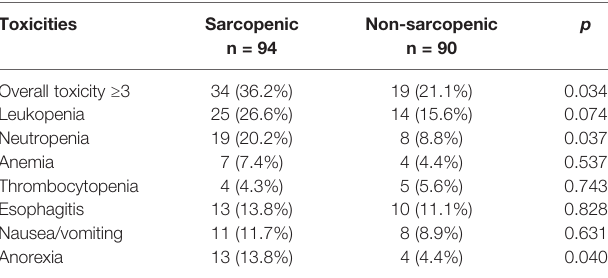
TABLE 3 | Comparisons of treatment-related toxicities between patients with and without sarcopenia.